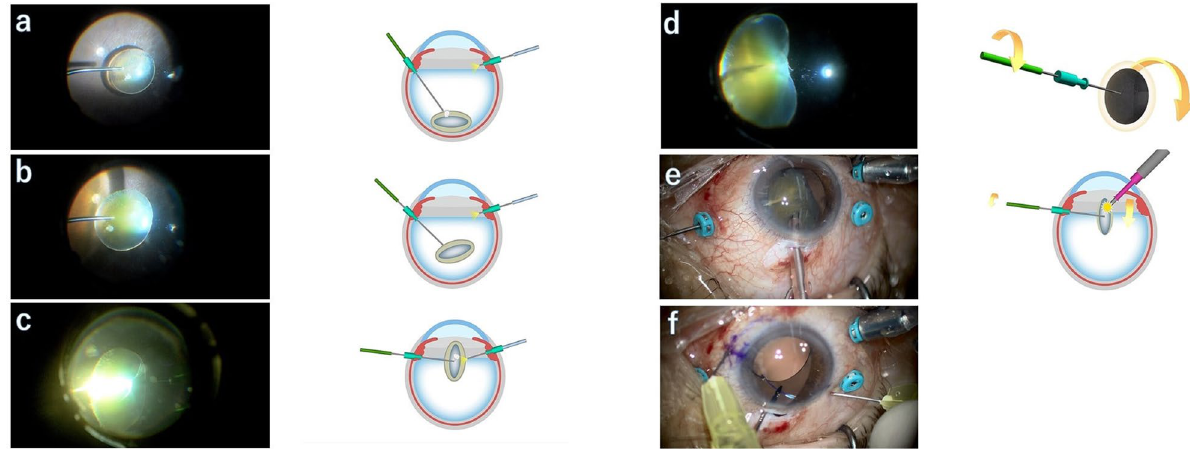
Figure 1. Kebab technique to remove the dropped nucleus of the lens. (Supplementary material S1). ( a ) A bipolar pencil touches the nucleus slightly, and surface coagulation is performed briefly. ( b ) The trapped nucleus is lifted up from the retina by the bipolar pencil. ( c ) The bipolar pencil recoagulates the lifted nucleus assisted by an endilluminator. ( d ) The bond becomes stronger, allowing the nucleus to be fully controlled by the bipolar pencil. ( e ) The lifted nucleus can then undergo phacoemulsification with complete control of its rotation. ( f ) After emulsifying the nucleus, the IOL is affixed by Yamane’s double-needle technique as